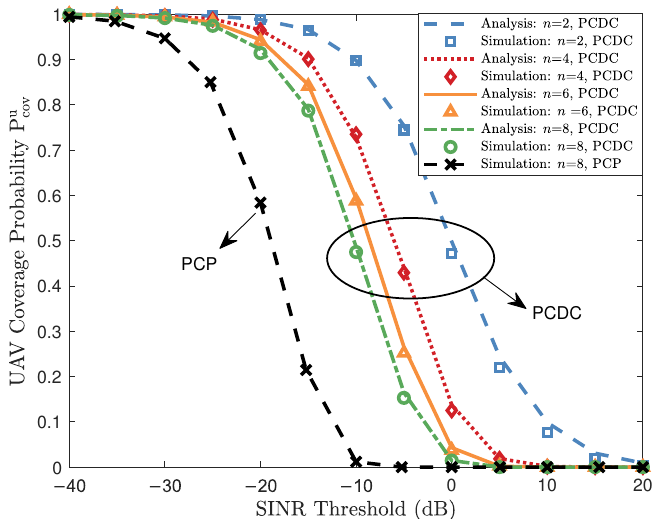
Figure 2. Coverage probability of UAV versus the SINR threshold γ u with different numbers of EUUs n within a cluster; the cluster radius a = 50 m; the transmit power of EUUs is 10 dBm.